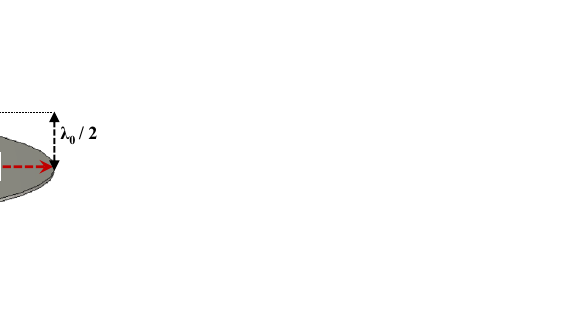
Figure 8. Configuration of a single layer uniform substrate